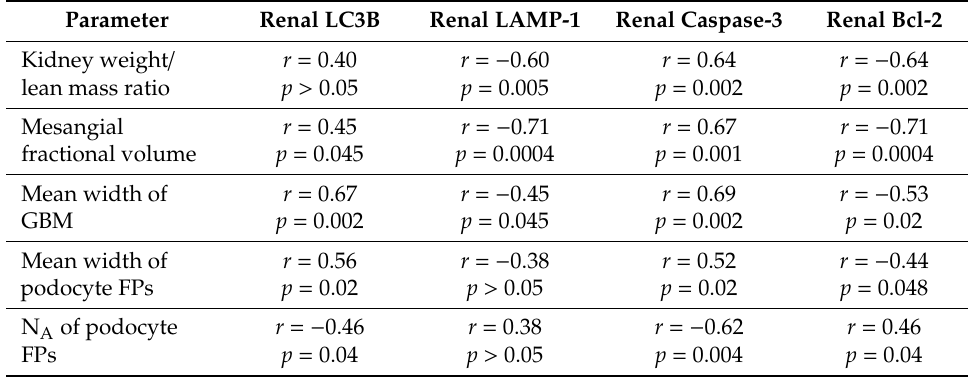
Table 8. Relationships between expression of autophagy and apoptosis regulators in the renal cortex and parameters of renal and glomerular